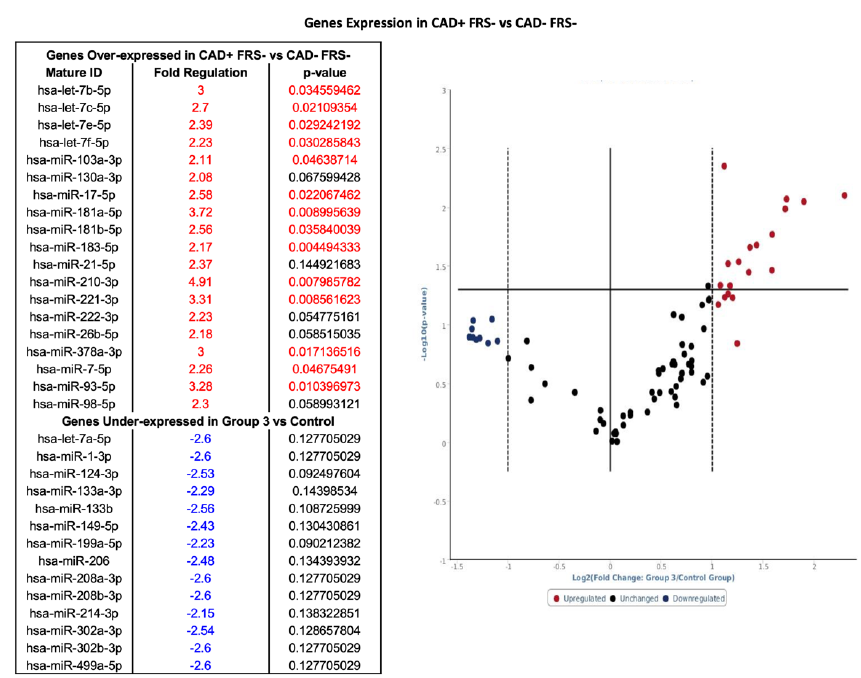
Figure 5. Volcano plot with corresponding table showing the comparison of miRNA assessed by microarray (84 genes) isolated from patients without CAD but FRS > 18 ( n = 7) versus heathy controls without CAD and FRS < 5 ( n = 9). Designation of significance (RED) was given to samples with fold increase > 2 and (Blue) was given to samples with fold decrease > 2. Samples with p values < 0.05 and fold change > 2 are found in the upper right quadrant and upper left quadrant. CAD—Coronary Artery Disease. FRS—Framingham Risk Score. Diagnostics 2020 , 10 , x FOR PEER REVIEW